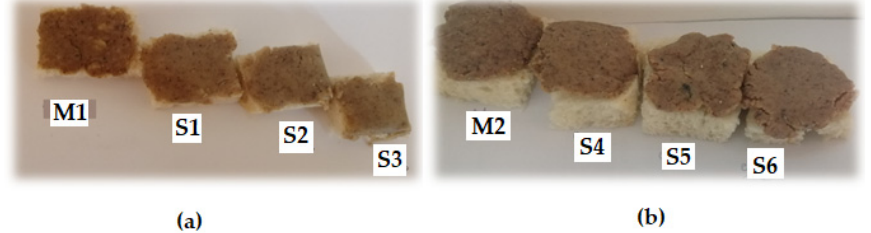
Figure 3. Slices of bread with walnut butter: ( a ) 3% maple syrup and different levels of xanthan gum (0.5, 1.5, 3%); ( b ) 5% Jerusalem artichoke powder and different levels of xanthan gum (0.5, 1.5,